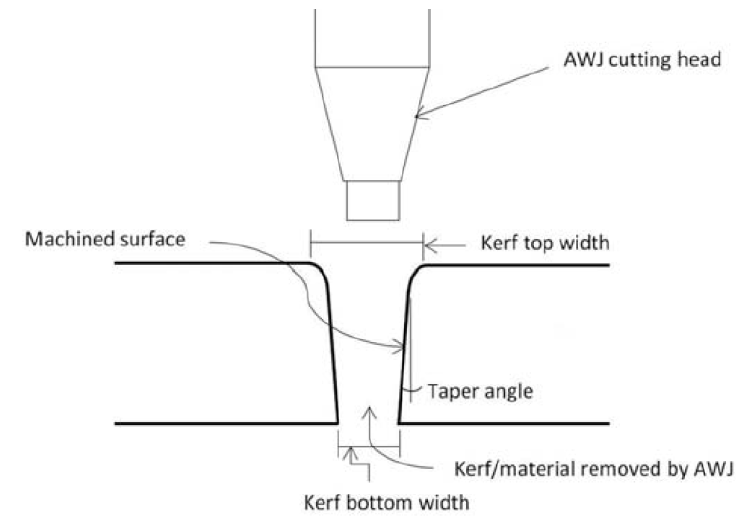
Figure 5. The Kerf Taper produced by AWJM [49].